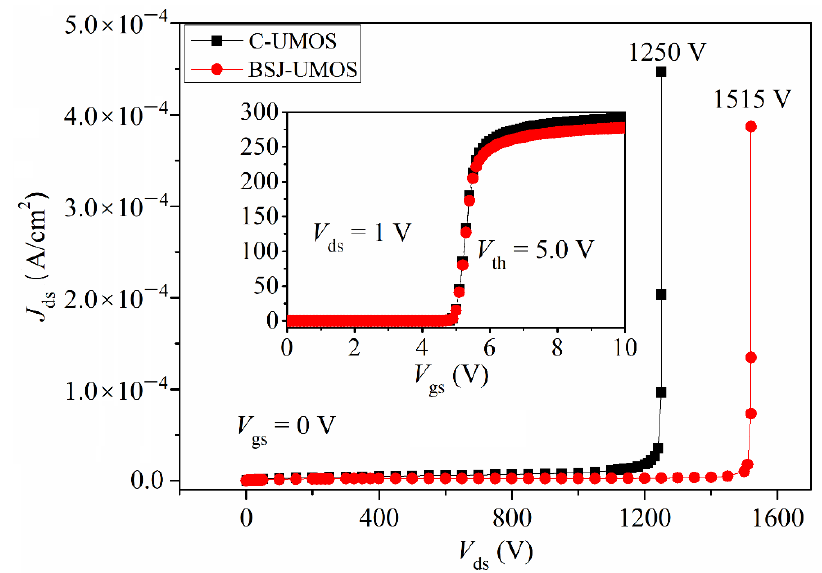
Figure 5. Comparisons of transfer and breakdown characteristics.